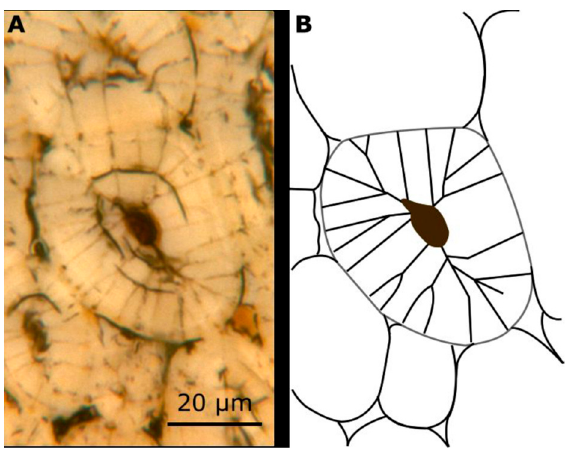
Figure 7. SEM images of sclereid cells from fracture surfaces. The cross-section shows the many cell wall layers that fill almost the entire cell lumen ( A ). The cell wall is traversed by pit canals ( B ), to which the lignified secondary cell wall layers (l2) align. In a sclereid cell oriented longitudinally to the direction of fracture, the crack has run into the cell wall and detached the outermost cell wall layers ( C ). When the primary cell wall (l1) and middle lamella is partly broken, the pit cavity becomes visible ( D ) and the bordered pits emerge from the fracture surface ( E ).